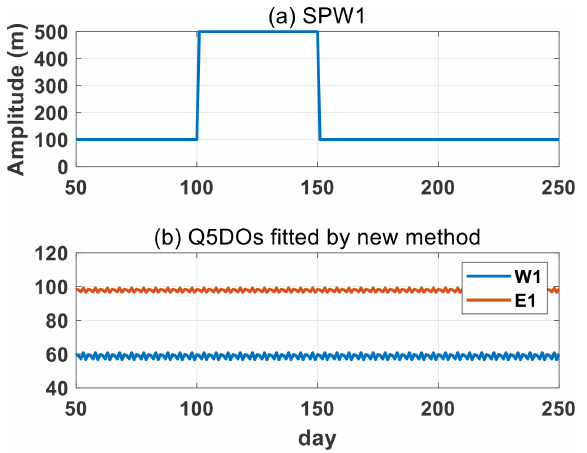
Figure 2. Simulations of the new fitting method based on synthetic data, including an SPW and westward and eastward Q5DOs with a zonal wave number of 1. (a) Daily variations in the SPW ampli- tudes. The phase of the SPW is 0. (b) Q5DOs obtained from the new fitting method. The amplitudes are 60 and 100m and the phases are − π/ 4 and π/ 5 for the westward and eastward Q5DOs, respectively.